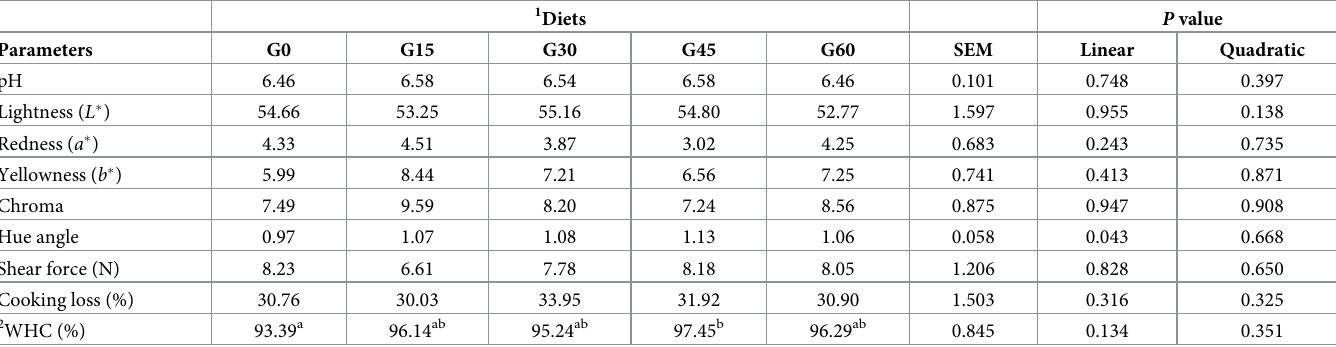
Table 7. Effect of red grape pomace-containing diets on meat quality traits of Hy-line Silver Brown cockerels. 1 Diets P